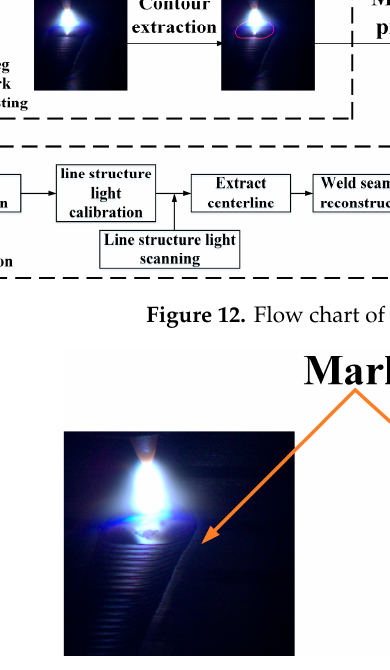
Figure 13. Molten pool mark frame and corresponding weld seam mark.